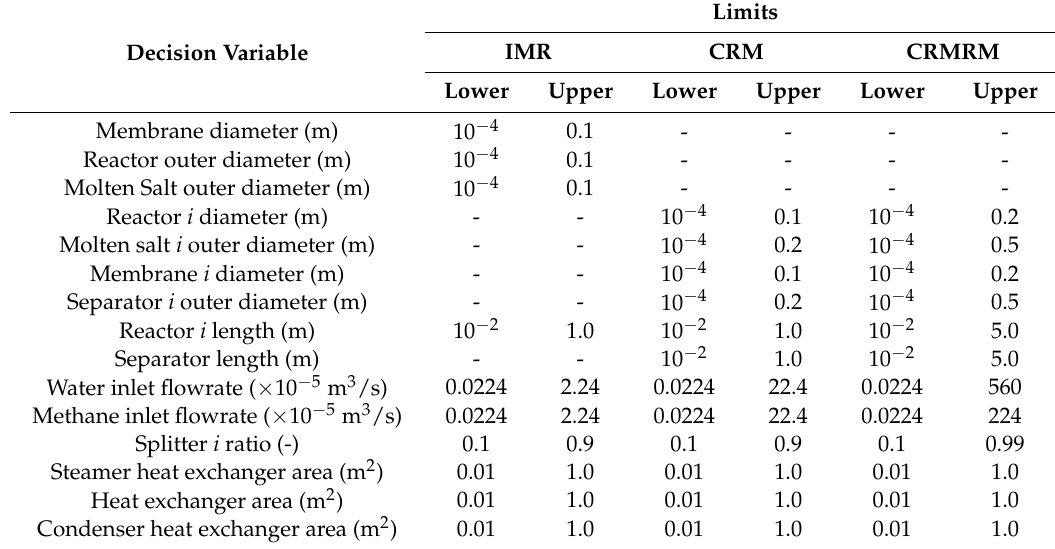
Table 1. Decision variable ranges employed in the optimization of the alternative configurations